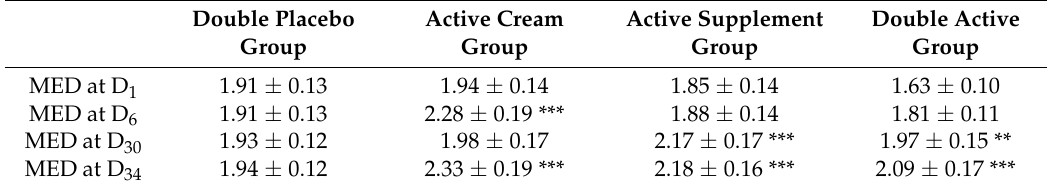
Table 1. Minimal Erythema Dose measurements before, during, and after melon concentrate application and/or